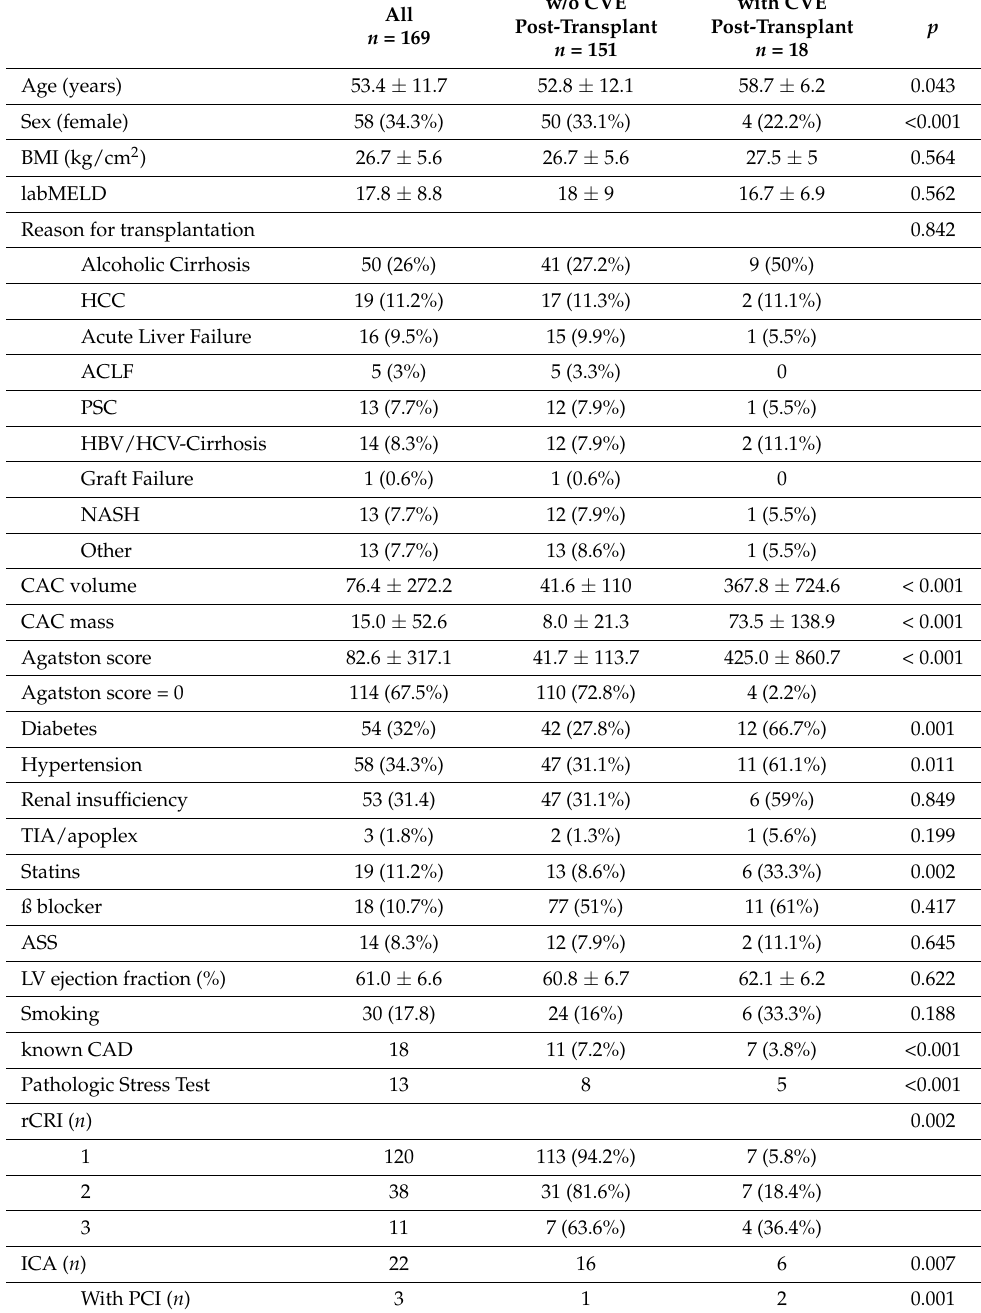
Table 1. Demographic and clinical characteristics of 169 single-center liver transplant recipients. Patients were discriminated between patients without a cardiovascular event (w/o CVE) and with a cardiovascular event post-transplant (with